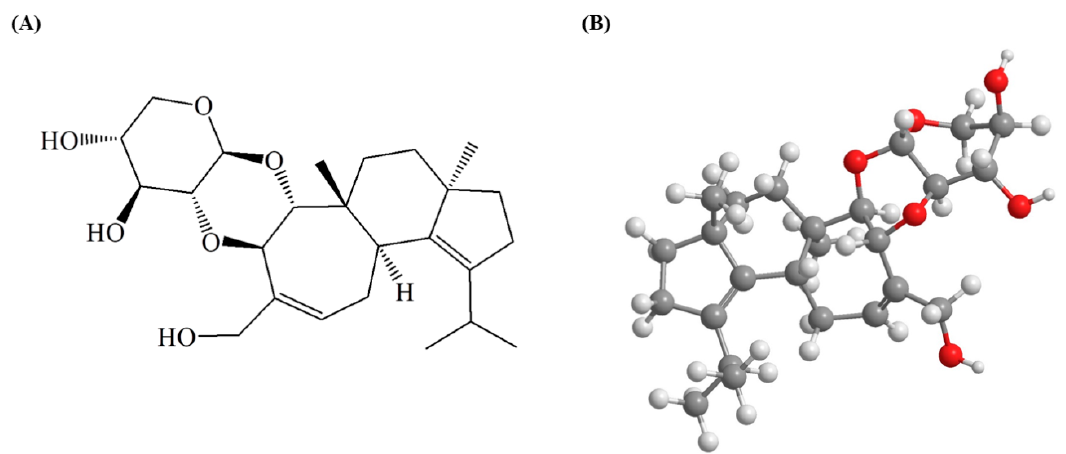
Figure 1. The chemical structure of erinacine C: ( A ) 2-dimensional structure; ( B ) 3-dimensional structure.